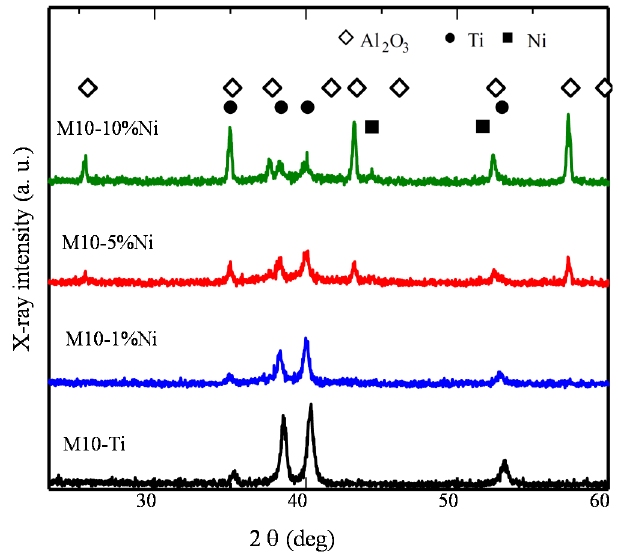
Figure 41. XRD patterns of M10- x Ni coatings